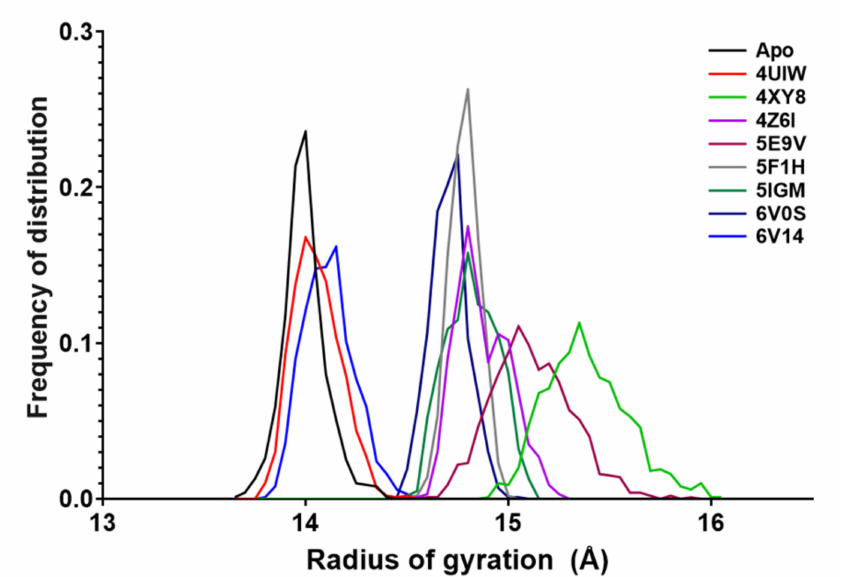
Figure 7. The radius of gyration of the 9 systems. The data were collected as the mean value at each timestep and plotted as the frequency of distribution.